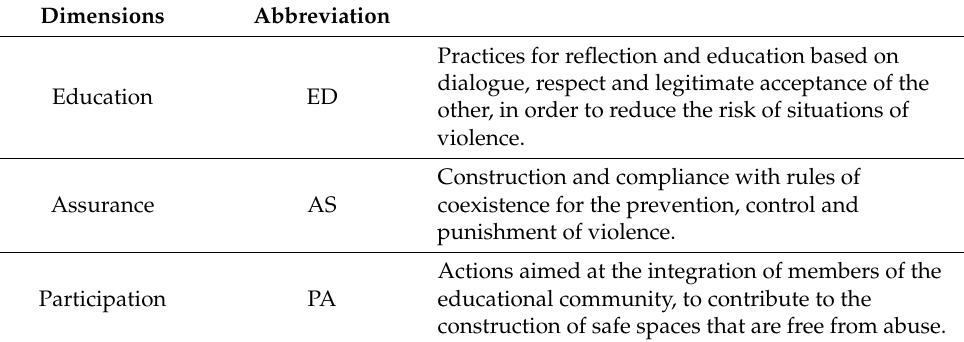
Table 6. Actions related to the dimensions of factor 2. Source: Muñoz et al.